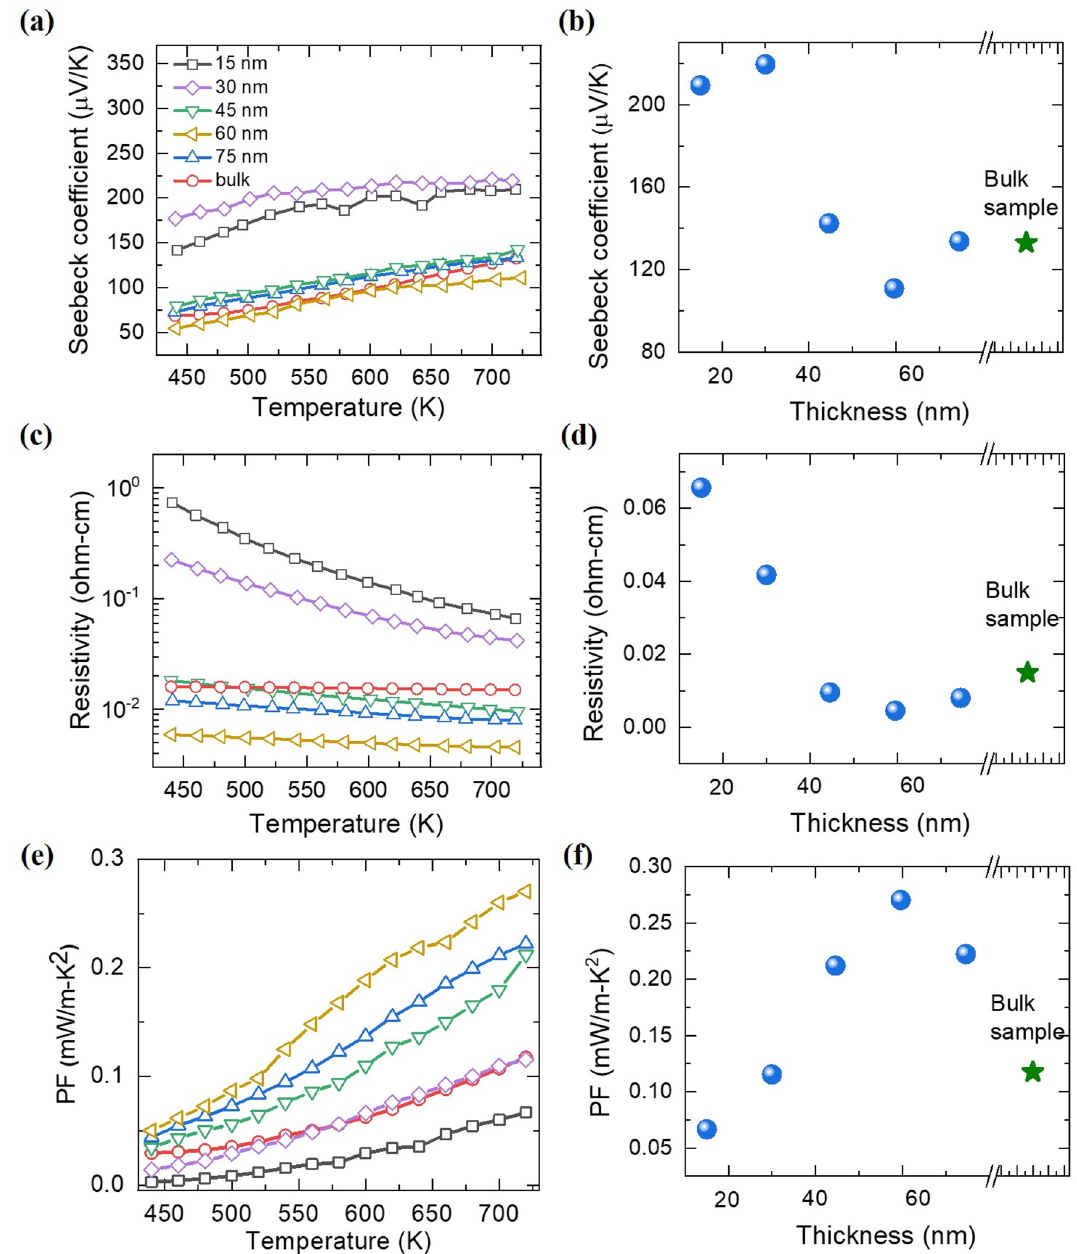
Figure 5. (a , c , e) The Seebeck coefficient, ( S ), resistivity ( ρ ), and power factors of various thin films and bulk CCO as a function of temperature ( T ); (b , d , f) show the comparisons of the S , ρ , and power factors at 720 K of CCO thin films and bulk